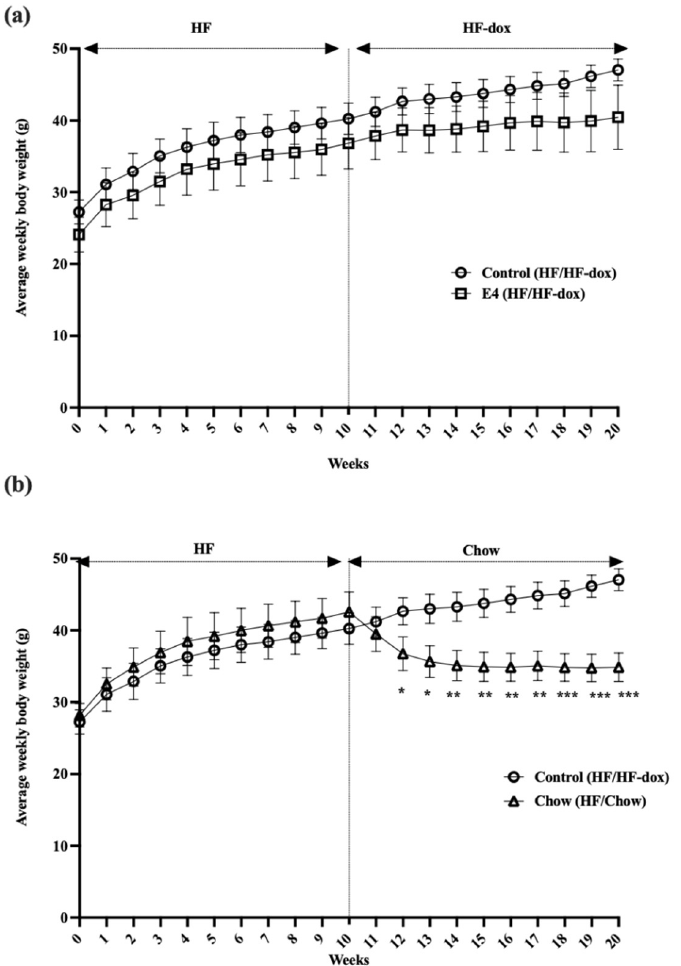
Figure 1. Changes in average weekly body weight. ( a ) Average weekly body weights in control, E4 and chow mice. Control mice show significant weight gain on HFD at the end of the study (week 20) compared with baseline (week 0), while E4 expression from week 10 attenuated weight gain among the E4 mice during the additional 10 weeks of HFD. ( b ) Average weekly body weight changes in chow mice following diet change, compared with control mice. Chow mice show significant weight loss following diet reversal at week 10 compared with control mice. n = 5; Welch’s t -test: * p < 0.05, ** p < 0.01, *** p < 0.001.